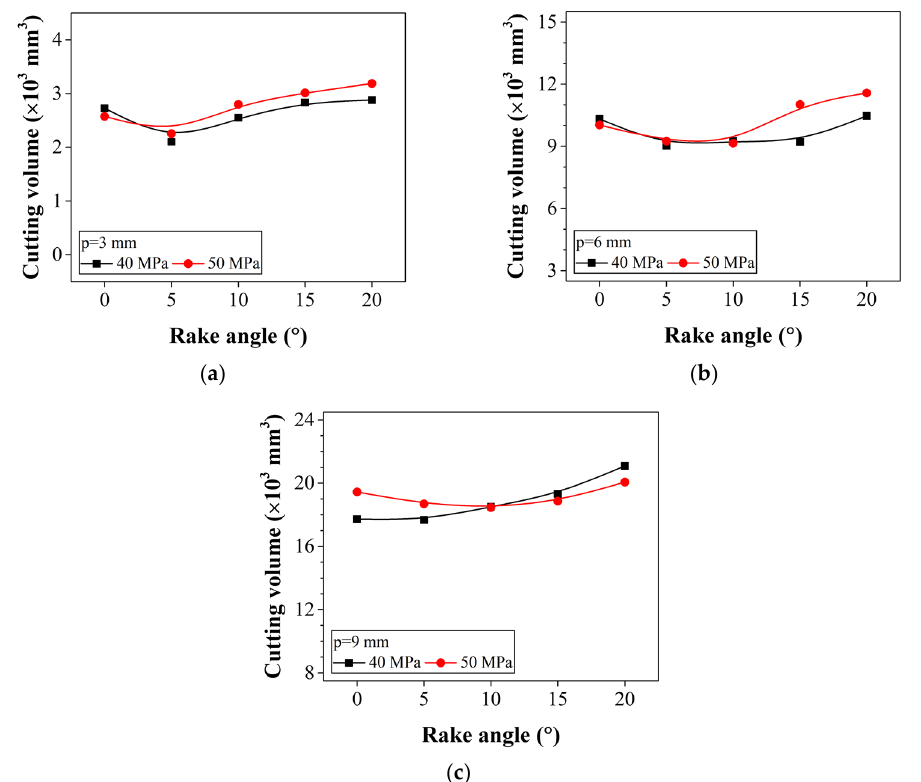
Figure 16. Relationship between the cutting volume and rake angle for depths ( p ) of: ( a ) 3 mm, ( b ) 6 mm, and ( c ) 9 mm. Table 6. Cutting volume and specific energy for different values of the rake angle.